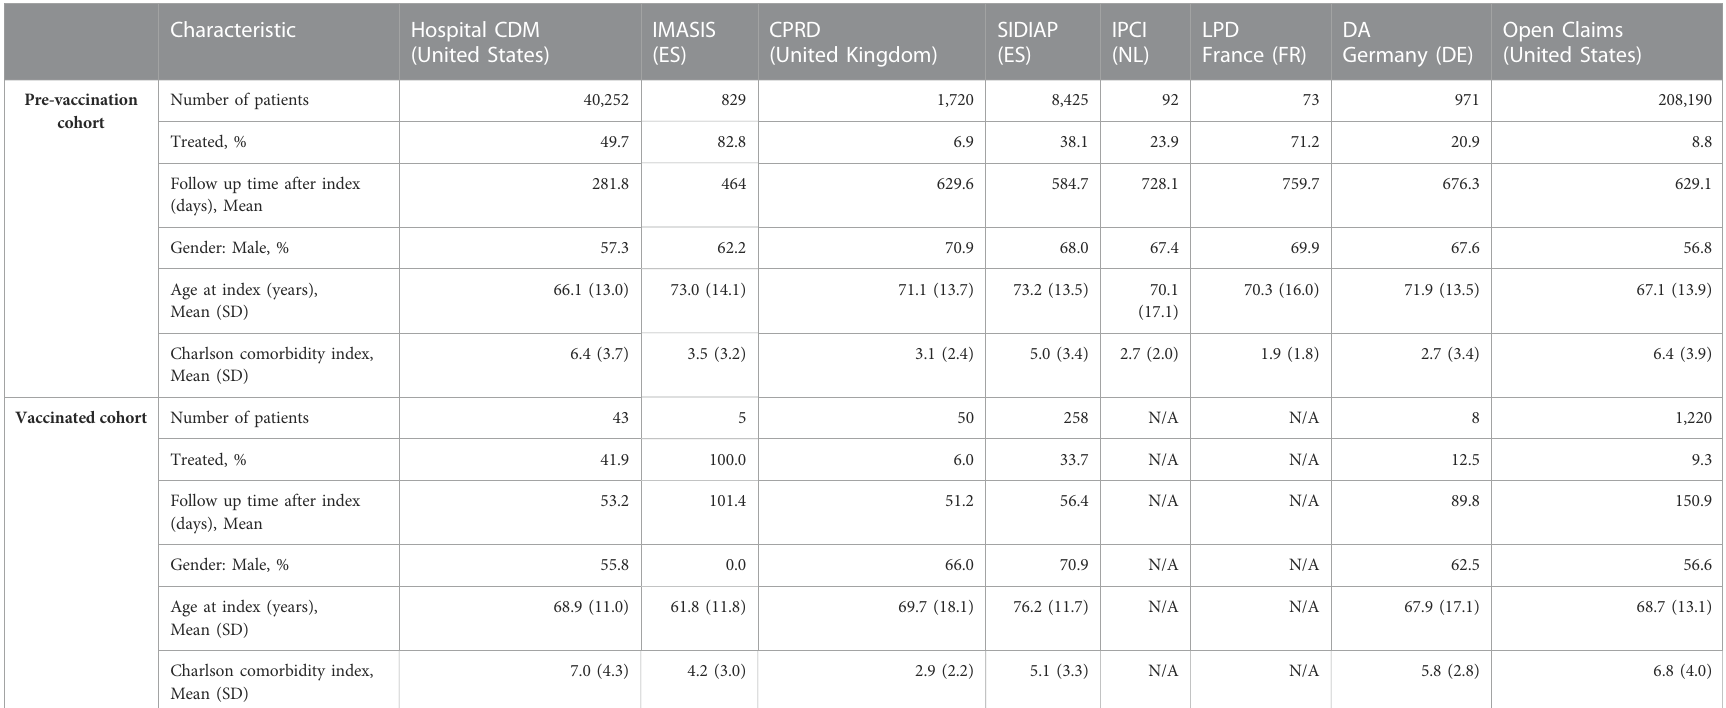
TABLE 3 Baseline characteristics of pre-vaccination versus vaccinated TTS